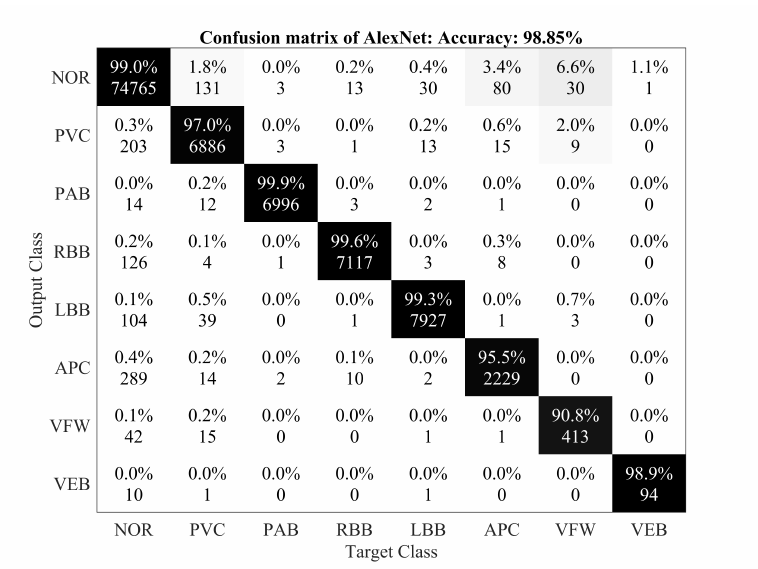
Figure 3. Confusion matrix for VGGNet.